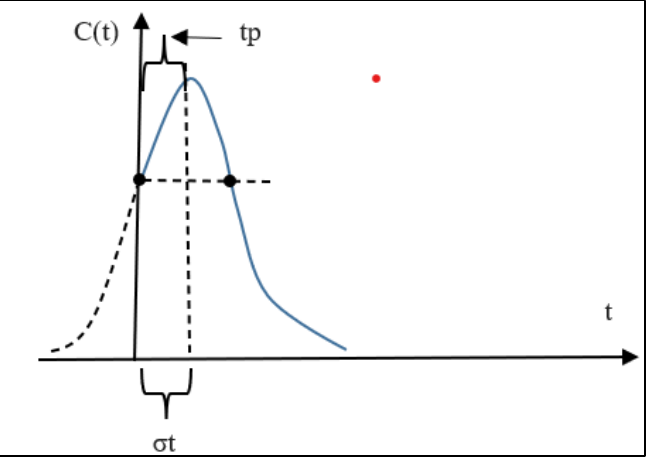
Figure 12: Minimum time in the evolution of the plume. Source: Authors, (2023).